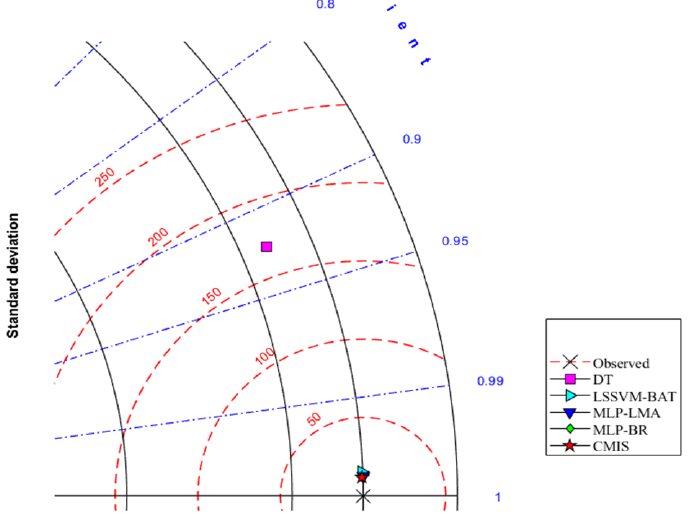
Figure 10. Zonation of the plotted points in the Taylor diagram based on Model (II).